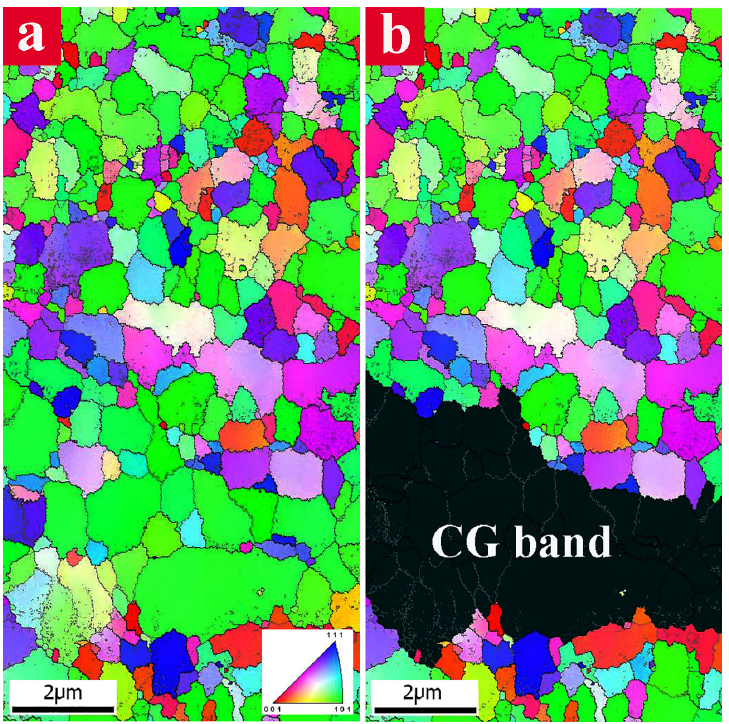
Figure 3. ( a ) Color-coded electron backscattered diffraction (EBSD) map of the 30 vol. % CG bimodal sample and ( b ) a CG band highlighted within the UFG matrix.